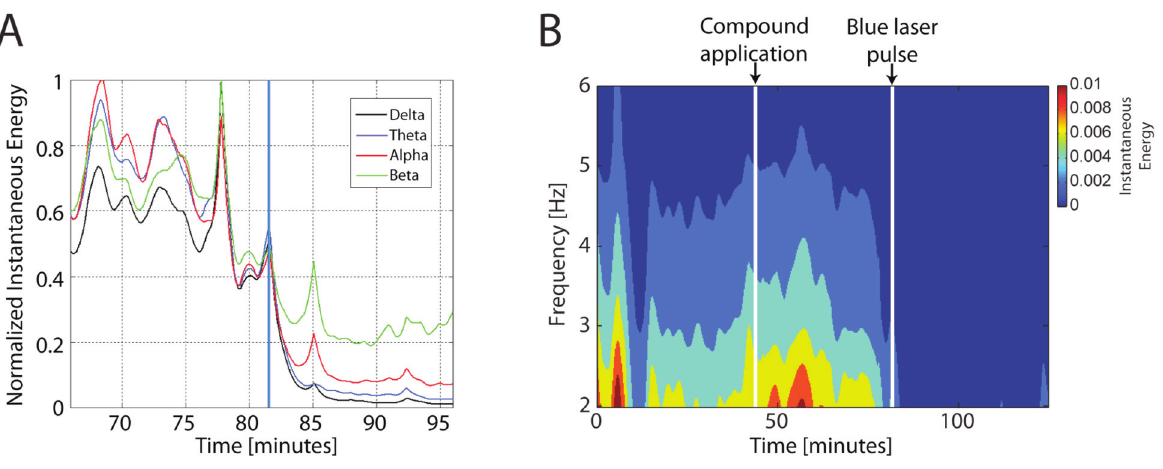
Figure 1. The photorelease of γ-amino-butyric-acid (GABA) decreases local field potentials (LFP). A , Instantaneous energy calcu- lated by the amplitude envelope of the analytical representation (AR) of the LFP signals for four frequency bands. The AR of a signal was computed using the Hilbert transform, which provides high temporal resolution for analyses at transitions. The blue vertical line indicates the exact time when the laser pulse caused inhibition of neural activity. A clear reduction of all frequency bands was noted following the laser pulse. B , A wavelet spectogram for Mouse 1 showing neural inhibition at the time of the laser pulse, which lasted at least 40